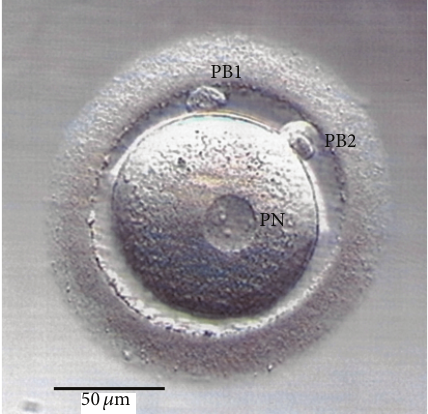
Figure 1: Following ICSI in our programme of assisted repro- duction, this oocyte displayed a single pronucleus (PN) and two polar bodies (PB1 and PB2) on the following morning. Because another pronucleus could not be detected after a second inspection several hours later, the cell was subjected to cytogenetic analysis and revealed a haploid karyotype